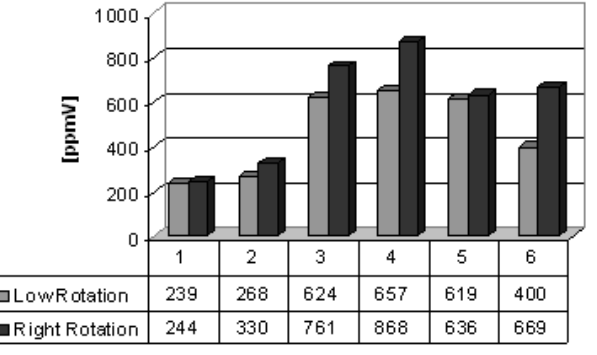
Figure 11. Nitrogen oxides gas concentrations